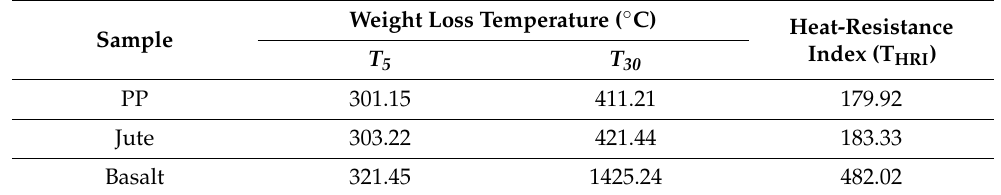
Table 6. Calculation of the heat-resistance index (T HRI ).